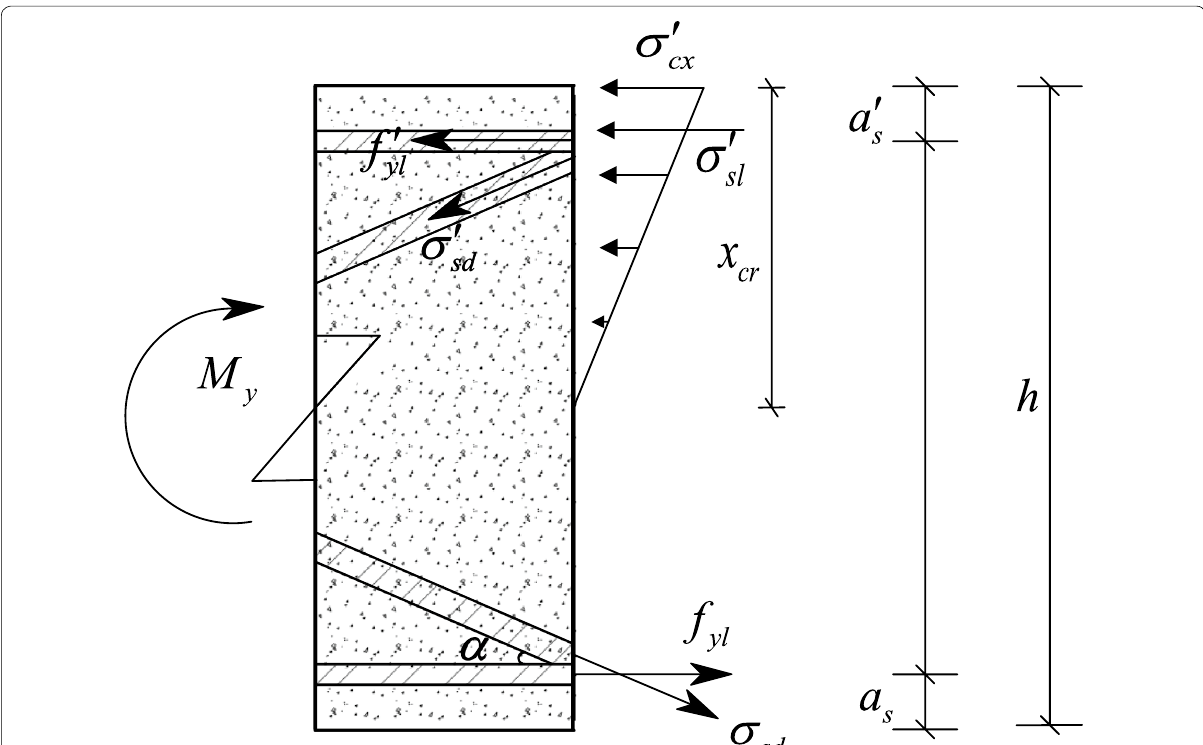
Fig. 7 The simplified computational diagram for cross-section of diagonally reinforced coupling beams at longitudinal reinforcement